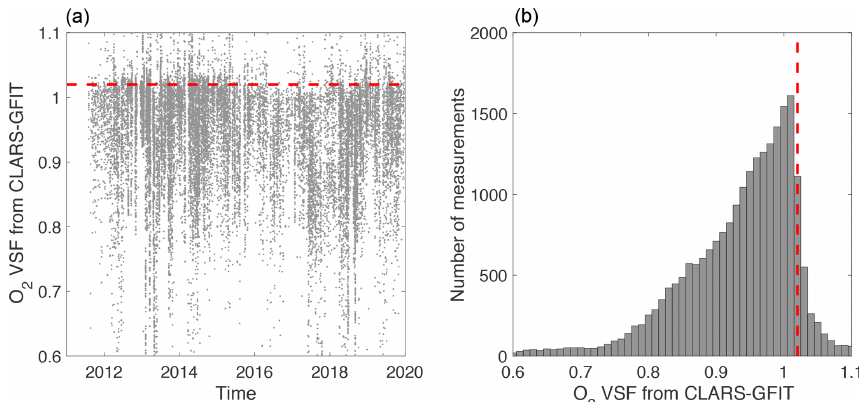
Figure A1. (a) Time series of O 2 volume mixing ratio (VMR) scale factor (VSF) and (b) histogram of VSF. The VSF value (indicated by the dashed red line) of ∼ 1 . 02 represents situations when the atmosphere is clear. See Sect. 3.1.1 for details.